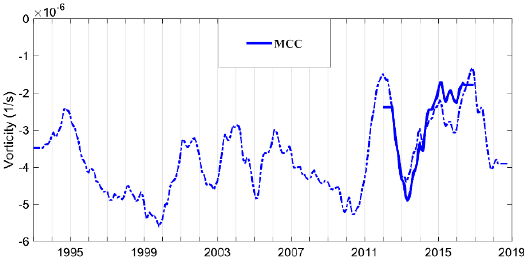
Figure 8. Time series of the spatially averaged, low pass filtered (13 month) vorticity field over the regions of the Malta plateau. Dashed-dotted lines are referred to the vorticity field derived from the AGV; continuous lines are related to the vorticity field derived from optimal currents from 2012 to 2016.